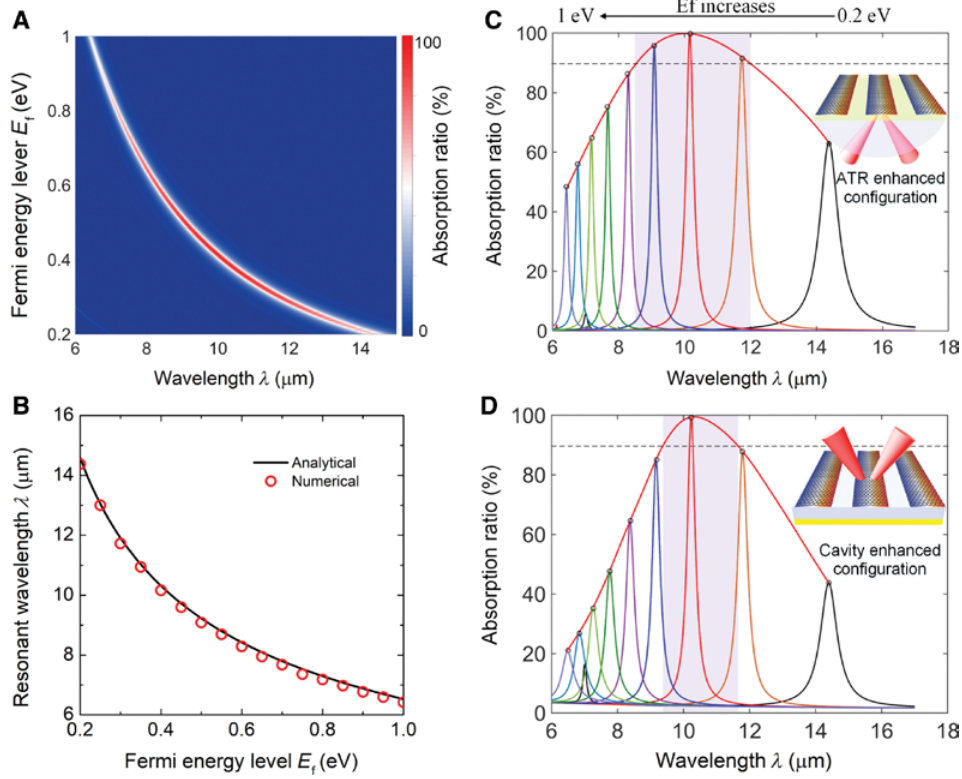
Figure 4: Tuning the plasmonic absorption by varying the Fermi energy of graphene. (A) Absorption mapping as a function of the Fermi energy and incident wavelength. (B) Comparison between numerical (hollow spheres) and analytical (black line) resonant wavelength with varying Fermi energy. (C) Absorption spectra with varying Fermi energy when θ = 40 ° . = 2, and the graphene carrier mobility is μ = 10,000 cm 2 V − 1 s − 1 . (D) Absorption spectra with varying Fermi The refractive index of prism is n p c energy for the cavity-enhanced configuration when the spacer thickness is set as T = 0.9 μ m. The inset shows the schematic of the cavity-enhanced